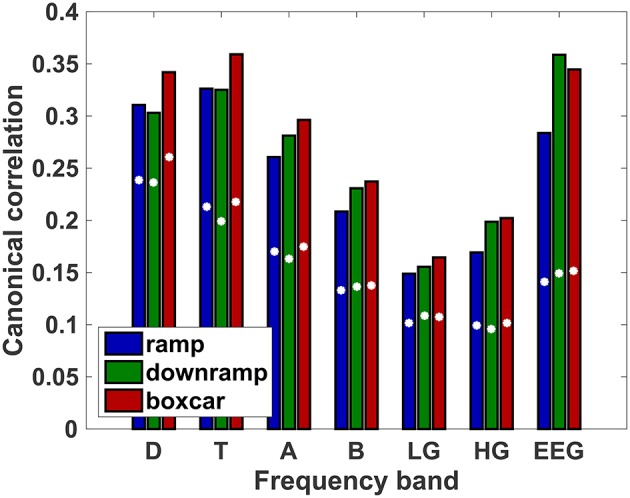
Mean canonical correlation between each regressor and the time course of whole-brain EEG/oscillatory power. White dots indicate 99th percentile of correlations obtained from regressors with randomized timing (i.e., they represent the chance level of each correlation).